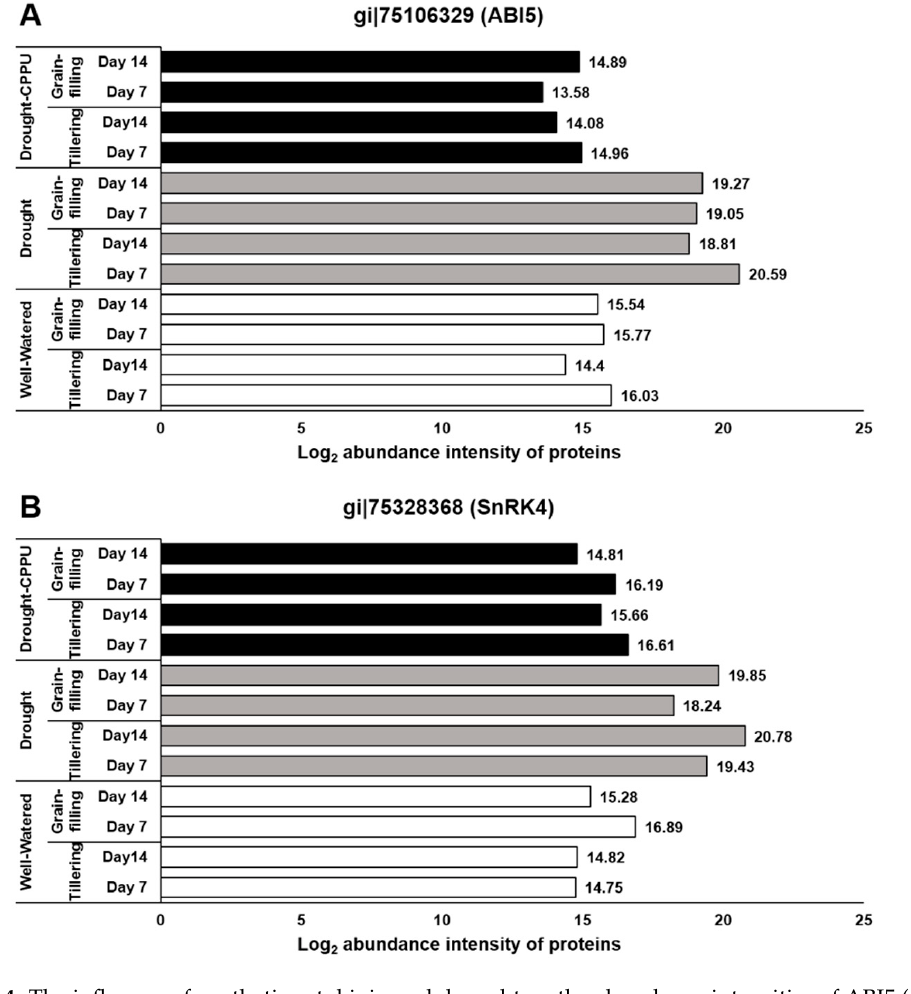
Figure 4. The influence of synthetic cytokinin and drought on the abundance intensities of ABI5 ( A ) and SnRK4 ( B ) proteins, implicated in ABA signaling and stomatal conductance, at the tillering and grain-filling stages of the rice. Protein abundance intensities, represented on the X- axis, are the highest log2 fold change values of technical replicates. [Well-Watered plants were maintained at a soil moisture tension of − 15 kPa during the treatment period. Drought stress was imposed by withholding water for up to 14 days. Soil moisture tensions of − 55 kPa and − 72 kPa were recorded at day 7 and day 14 during the treatment, respectively. CPPU treatment was given by foliar spraying plants with a 5 mg / L solution of CPPU at the rate of 25 mL / plant on day 6 of drought